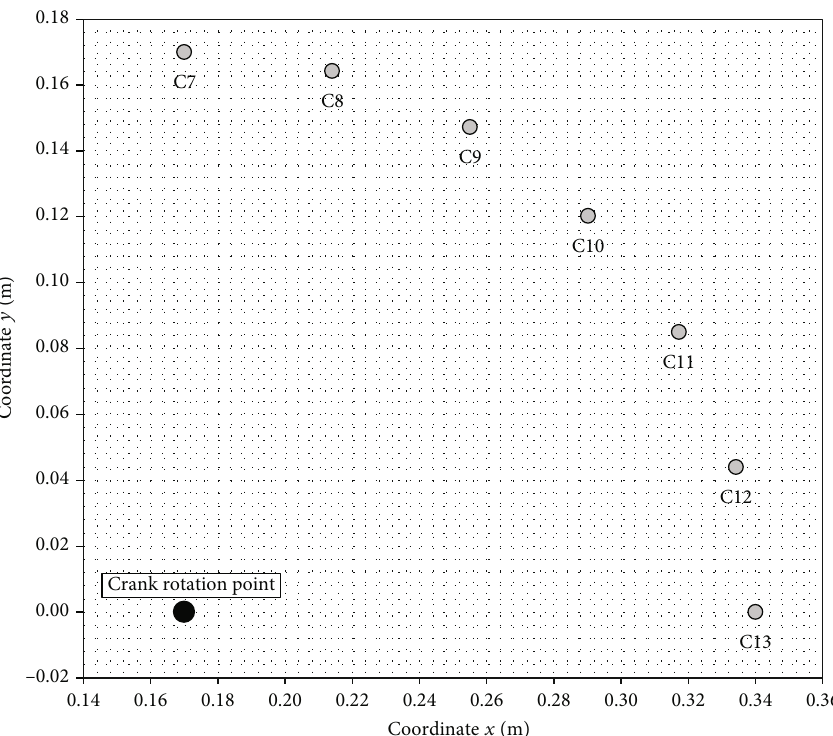
Figure 10: The measuring points for the crankset (phases C II and C IV).